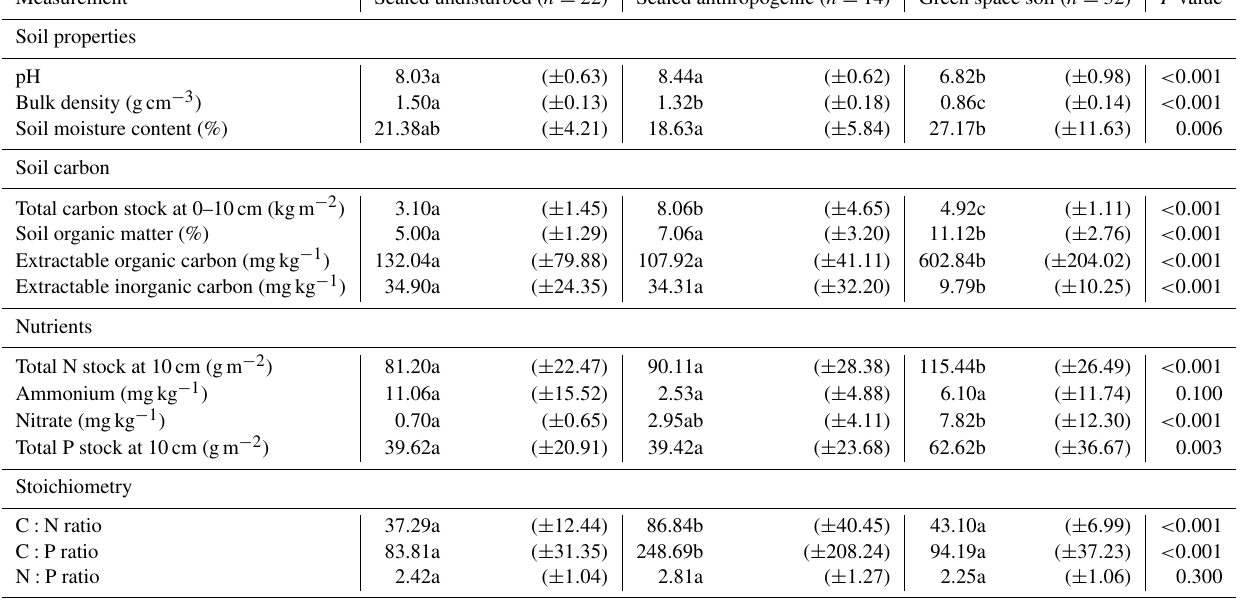
Table A1. Urban soil measurements showing the mean ( ± SD). Different letters indicate a statistically significant difference between soil categories at the 0.05